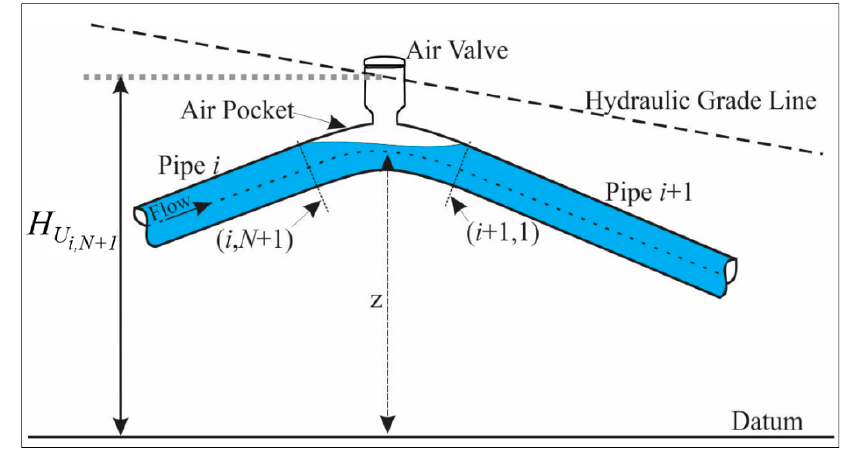
Figure 2. Notation for the air pocket.